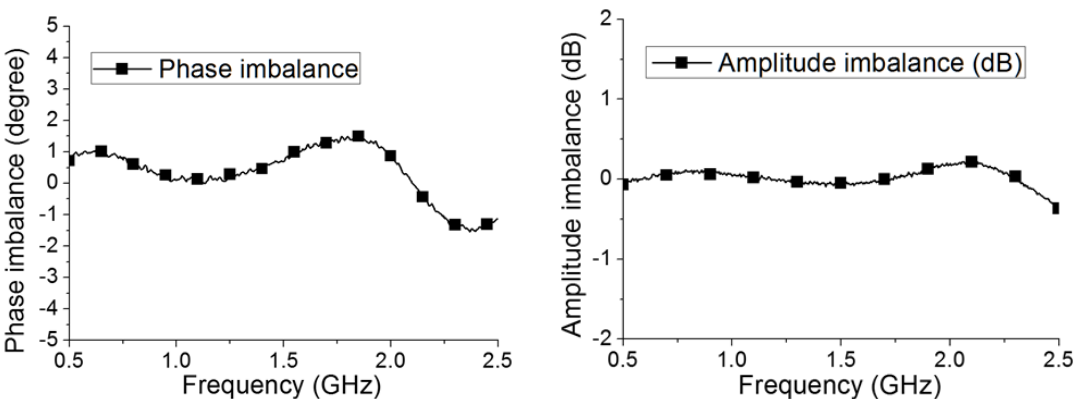
Figure 9. Measured phase and amplitude imbalance of the fabricated prototype.